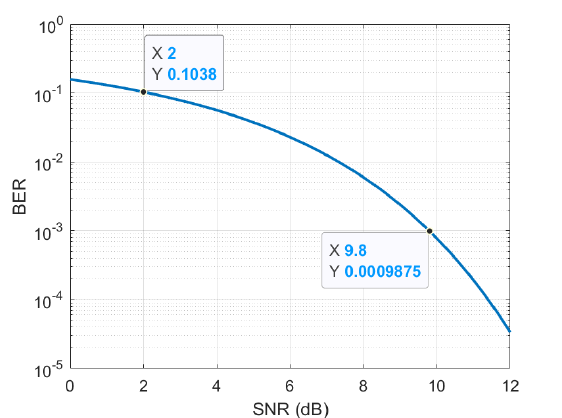
Figure 7. Compact antenna of [37]. QPSK modulation, φ 0 = 180 ◦ , SNR( φ 0 ) = 12 dB, PE DDM = 100% (conventional). Average radiation pattern ( a ) and BER ( b ) in the XY plane.